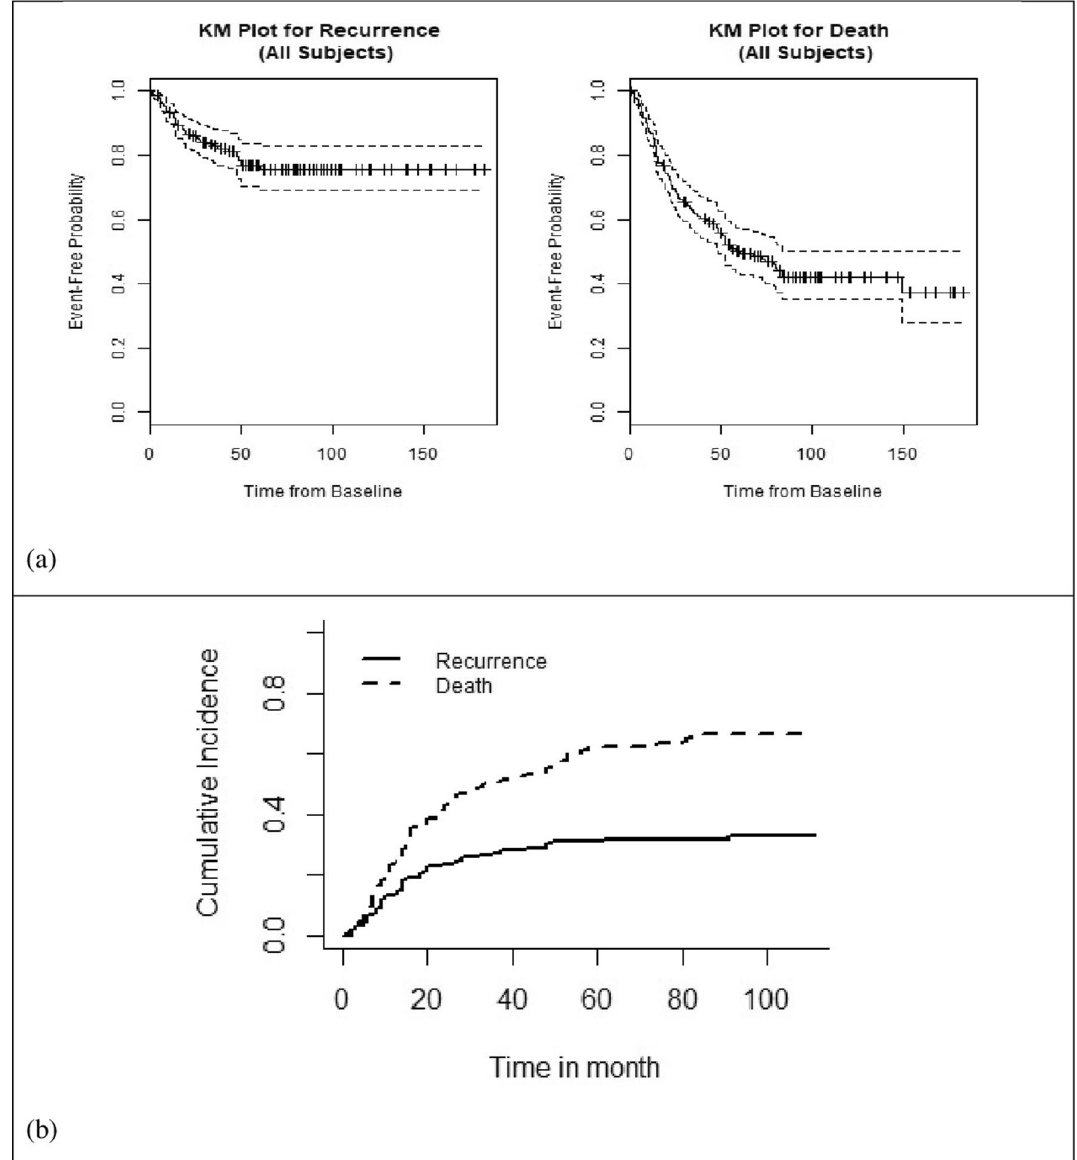
Figure 1. ( a ) Kaplan–Meier (KM) survival curves for recurrence and death times; ( b ) cumulative incidence for recurrence and death after